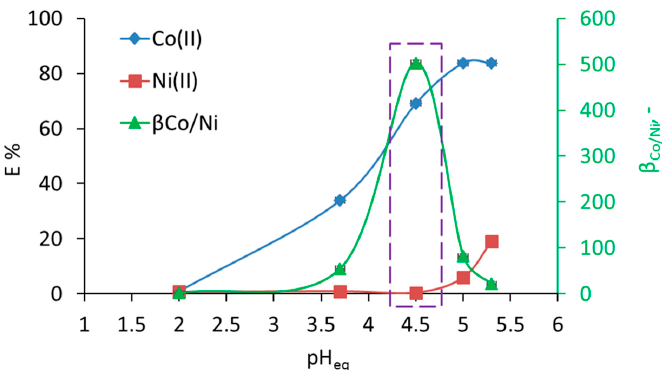
Figure 4. Effect of equilibrium pH (pH eq ) on the extraction percentage of Co(II) and Ni(II), and separation factor between Co(II) and Ni(II), at 20% v/v Cyanex 272, 5% v/v TBP, 75% v/v kerosene (Exxsol